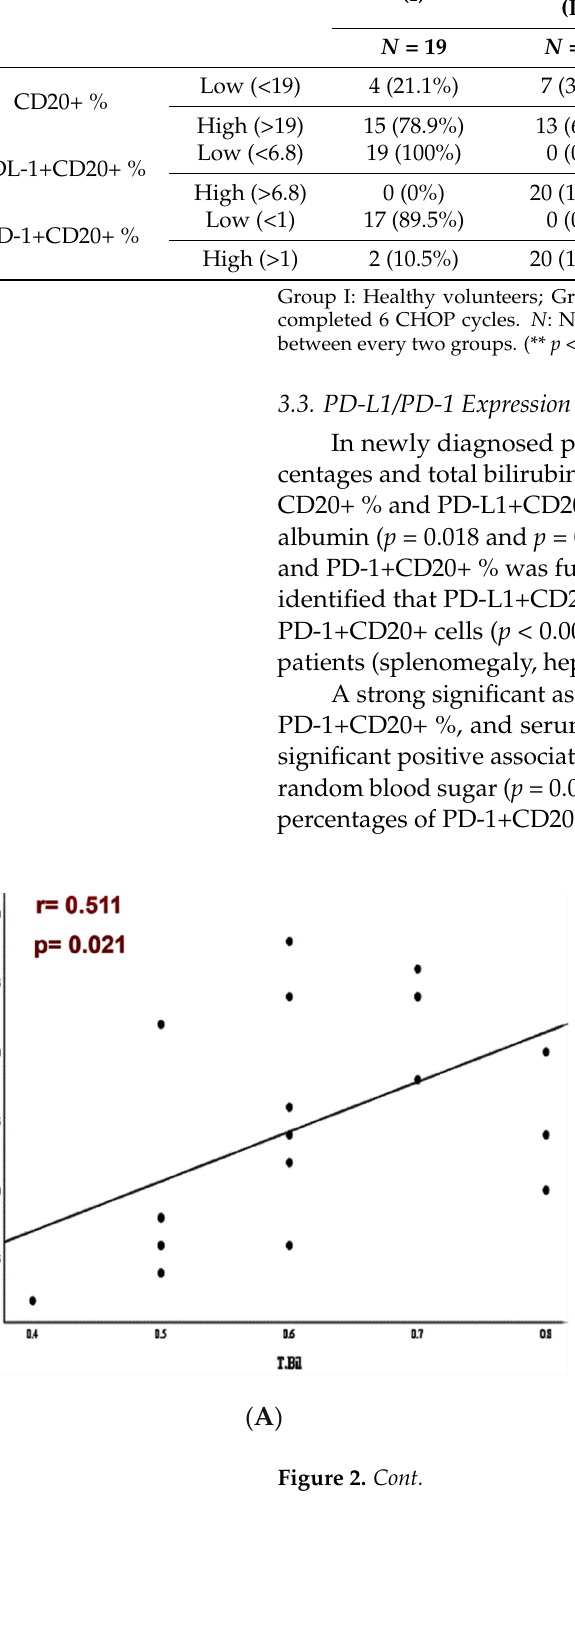
Table 4. Low versus high CD20+ %, PD-L1+CD20+ % and PD-1+CD20+ %.